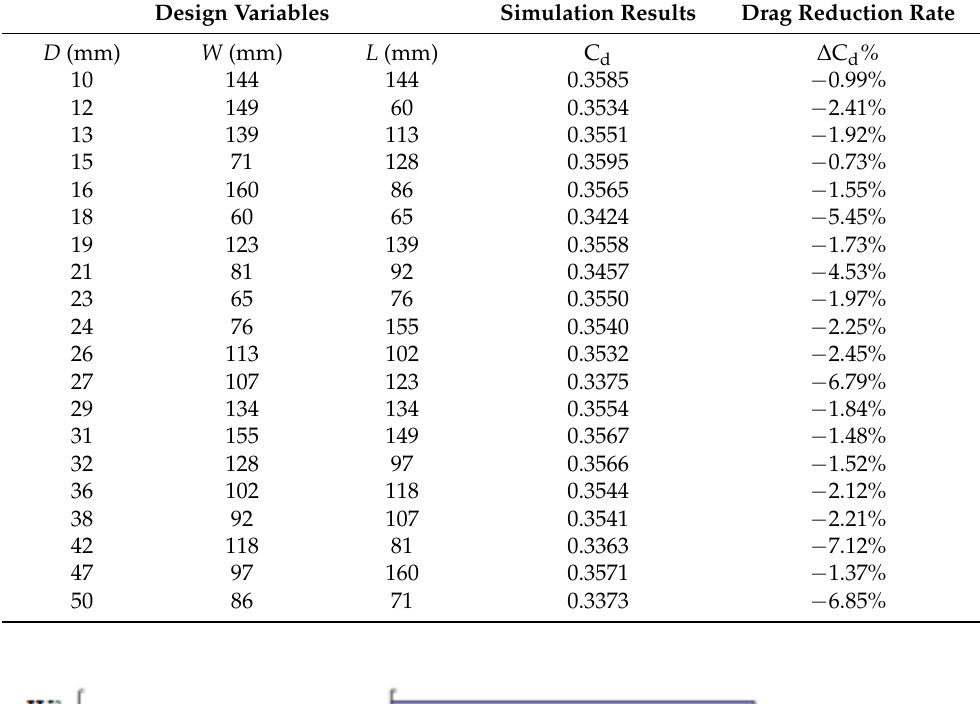
Table 5. Sample points and simulation results.